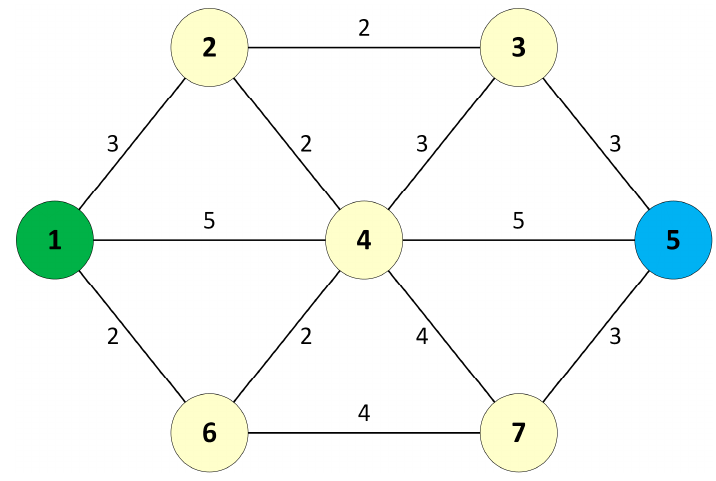
Figure 1. A sample network with seven nodes.